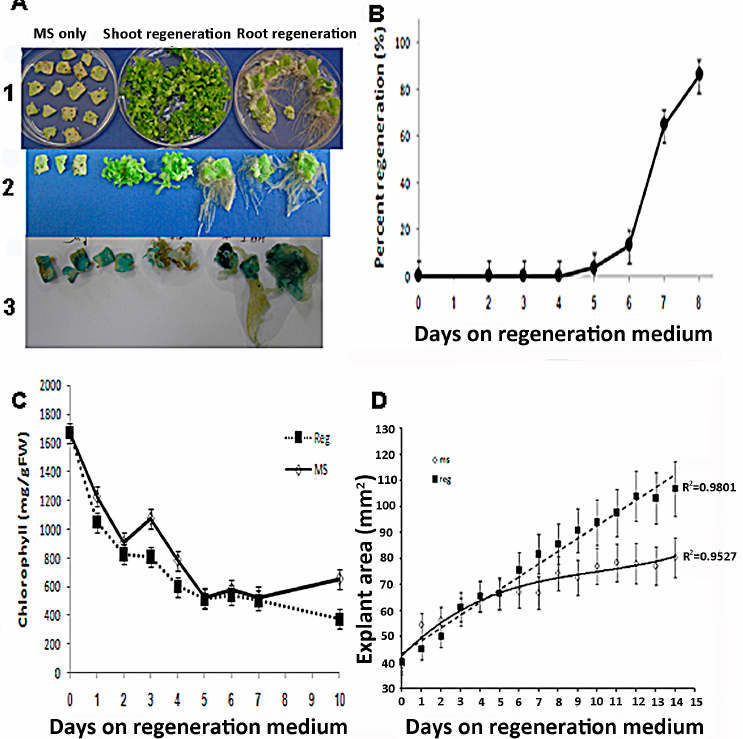
Figure 1. Tobacco leaf segments regeneration. ( A 1) Tobacco leaf segments were placed on MS nutrient medium or Regeneration medium, including auxin and cytokinin or MS medium (see Materials and Methods) containing auxin only (4.44 M IAA). Thirty days after placement on a specific medium, the segments were pictured. ( A 2) Close-up of leaf segments from the plates in ( A 1). ( A 3) Leaf segments from transgenic tobacco expressing a cytokinin reporter gene ARR5::GUS show responsiveness to cytokinin 30 days on the respective media described in ( A 1). ( B ) Time on regeneration medium that is required to induce shoots from competent tobacco leaf segments. Leaf segments were placed on regeneration medium for the indicated time and then transferred to MS medium for 30 days. Percent of shoots forming leaf segment was recorded after 30 days on MS medium + SE. Each point represents three plates with 20 segments. ( C ) Chlorophyll content of leaf segments on MS or regeneration medium. Leaf segments were placed on agar plates with MS only (MS) or with added growth regulators (REG), and chlorophyll was extracted and determined from each segment. Chlorophyll content per gram fresh weight from leaf segment was recorded on ten segments every day + SE. ( D ) Area of leaf segments explants during the first two weeks on MS or REG medium. Leaf segments were placed on agar plates with MS salts only (MS) or with added growth regulators (REG), and the area of segments was recorded daily to measure cell proliferation. Size of leaf segment was recorded 20 segments every day on the two media + SE.